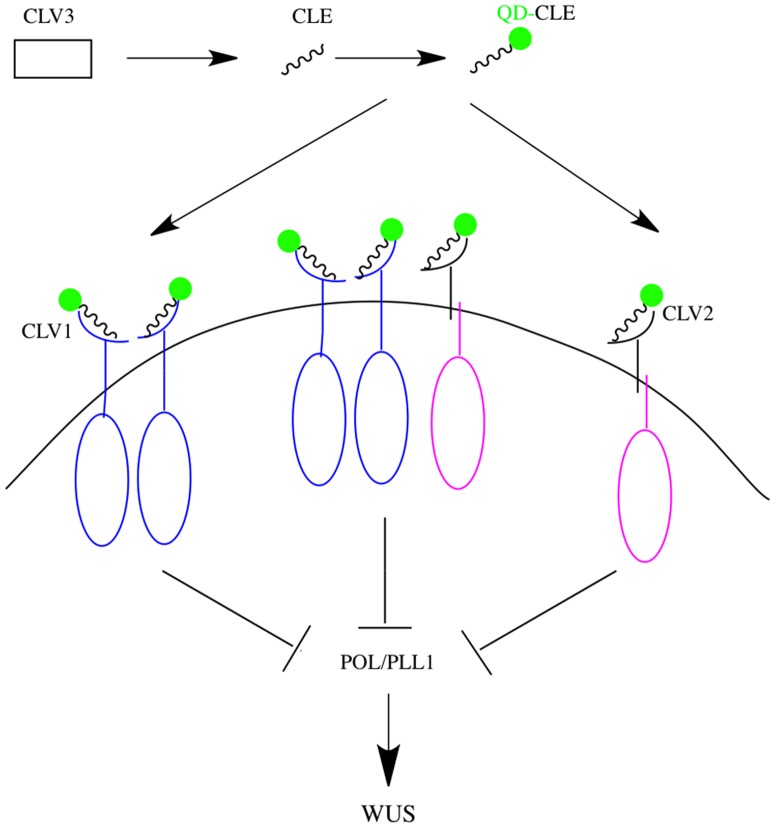
A model for CLV signaling (Adapted from [46] and [47]).